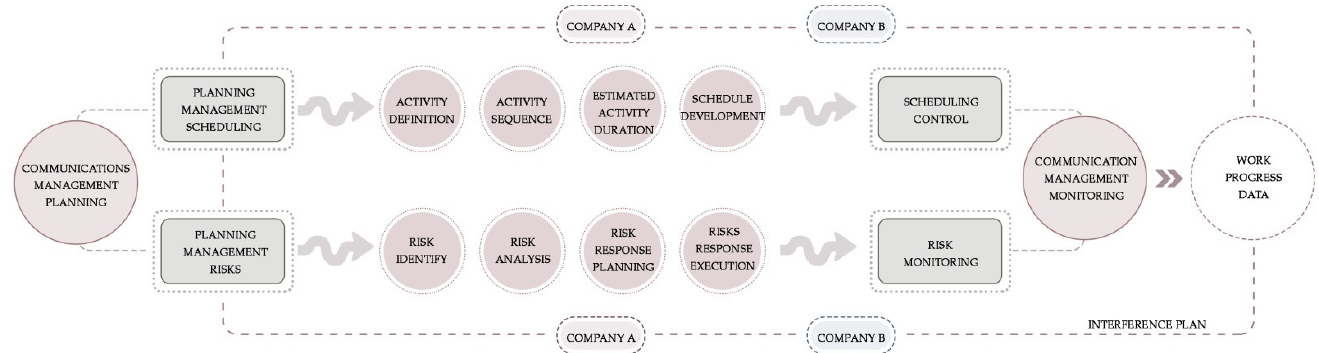
Figure 7. Interference plan framework—Model Smart Management.